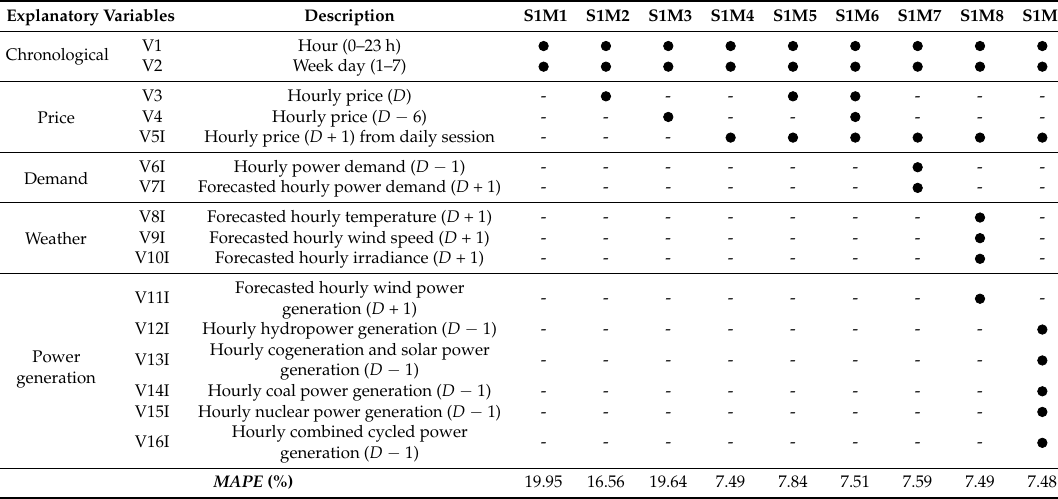
Table 8. ISMPF models for intraday session 1 and their MAPEs